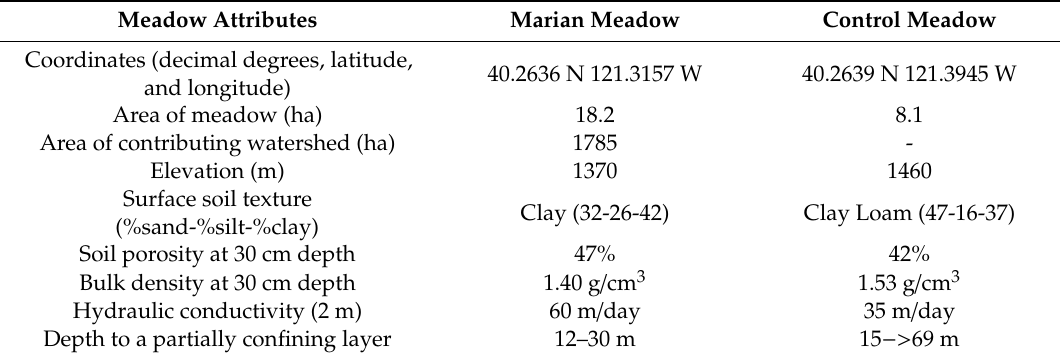
Table 1. Attributes of Marian Meadow and Control Meadow (adapted from Surfleet et al. [10]). Meadow